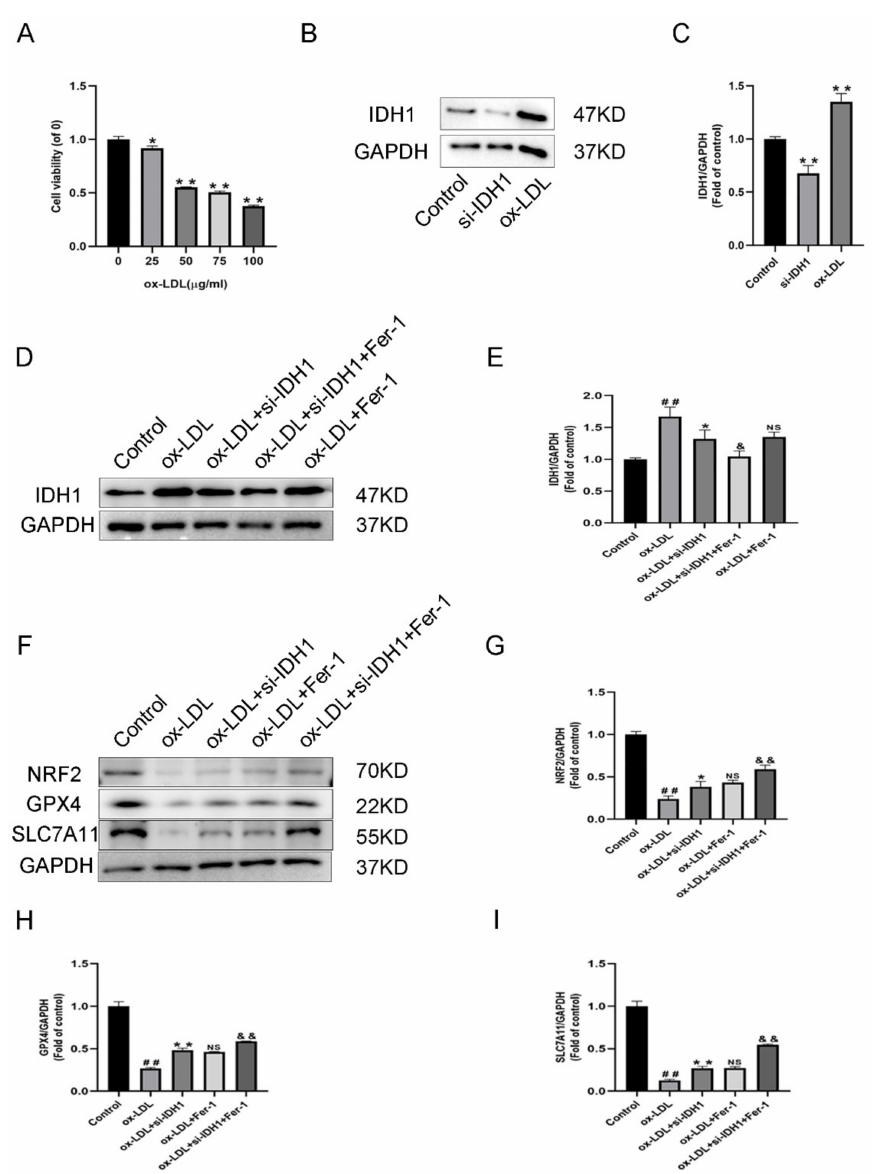
Figure 4. Expression of IDH1 in ox-LDL-induced foam cells. ( A ) Viability of RAW264.7 cells treated with ox-LDL (25, 50, 75, 100 µ g/mL) for 24 h. * p < 0.05, ** p < 0.01 vs. control group. ( B , C ) Western blot was used to detect the levels of IDH1 protein expression. ## p < 0.01 si-IDH1 treatment group vs. control group; * p < 0.05, ** p < 0.01 ox-LDL-treated group vs. control group. ( D , E ) Western blot was used to detect the levels of IDH1 protein expression. ## p < 0.01 vs. control group; * p < 0.05, ** p < 0.01 vs. ox-LDL-treated group; & p < 0.05, && p < 0.01 vs. ox-LDL and si-IDH1 treatment group. NS vs. ox-LDL and si-IDH1 treatment group. ( F – I ) NRF2, GPX4, and SLC7A11 expression. ## p < 0.01 vs. control group; * p < 0.05, ** p < 0.01 vs. ox-LDL-treated group; NS vs. ox-LDL and si-IDH1 treatment group. & p < 0.05, && p < 0.01 vs. ox-LDL and Fer-1 treatment group. NS, not significant. Data are presented as mean ±